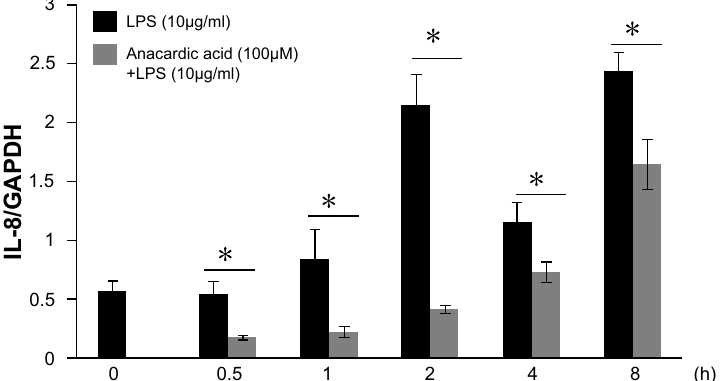
Figure 7. Time course analysis of anacardic acid on lipopolysaccharide (LPS)-stimulated interleukin-8 (IL-8) gene activation in A549 cells in vitro . Anacardic acid at 100μM treated 1 hr before LPS (10μg/ml) stimulation showed a significant inhibitory effect on LPS-induced IL-8 gene activation. After 0 ~ 8hrs, the levels of IL-8 mRNA were analyzed by quantitative reverse transcription polymerase chain reaction (qRT-PCR). The IL-8 mRNA levels were normalized to glyceraldehyde-3-phosphate dehydrogenase (GAPDH) levels. Data were expressed as mean±SEM. *P<0.05 (Mann-Whitney U test),